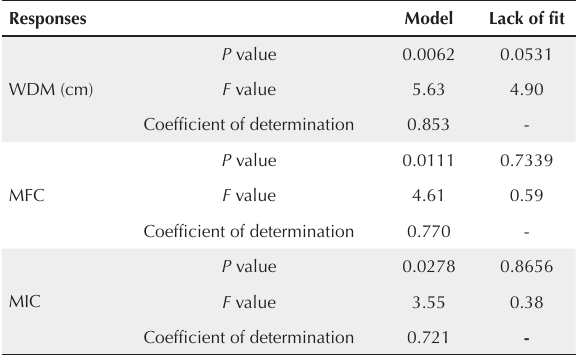
Table 3. Analysis of variance Responses Model